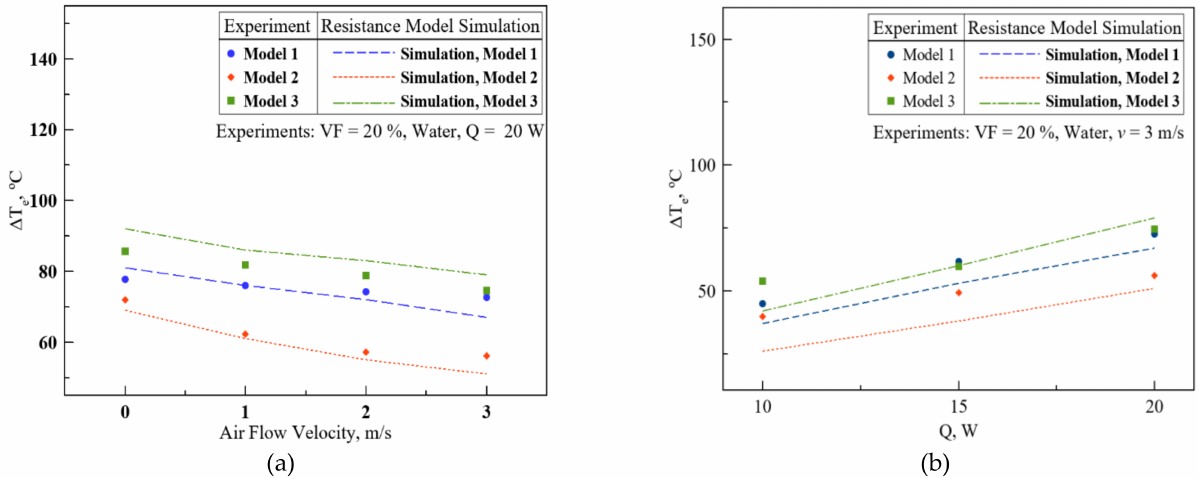
Figure 13. Comparison between the experiment and the resistance model simulation. ( a ) Effect of air flow velocity; ( b ) Effect of heat